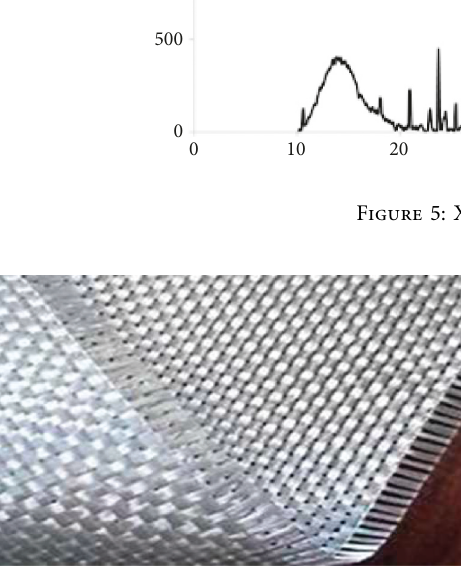
Figure 6: GFRP sheets.